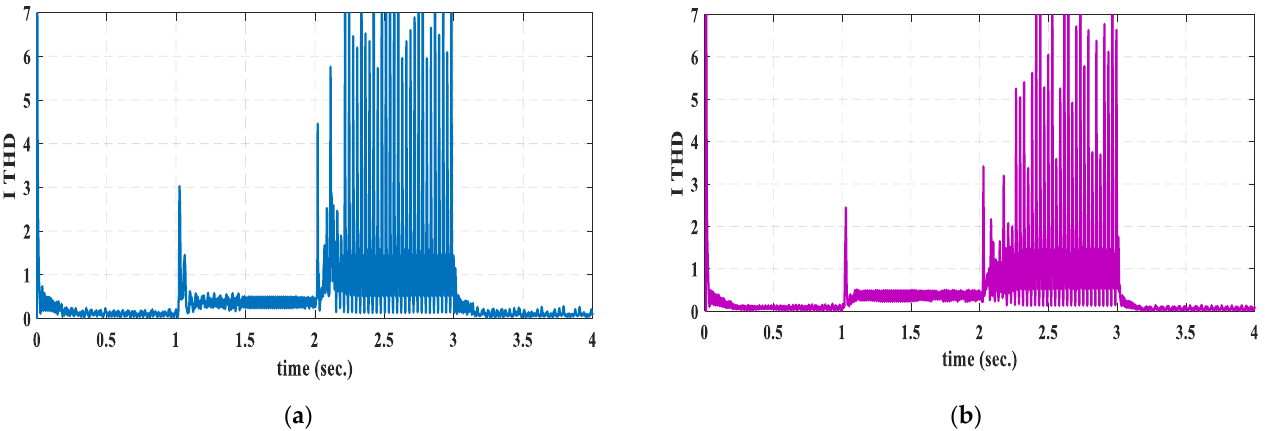
Figure 9. THD in current–time characteristics: ( a ) 3-phase inverter and transformer, ( b ) with 6-phase inverter.